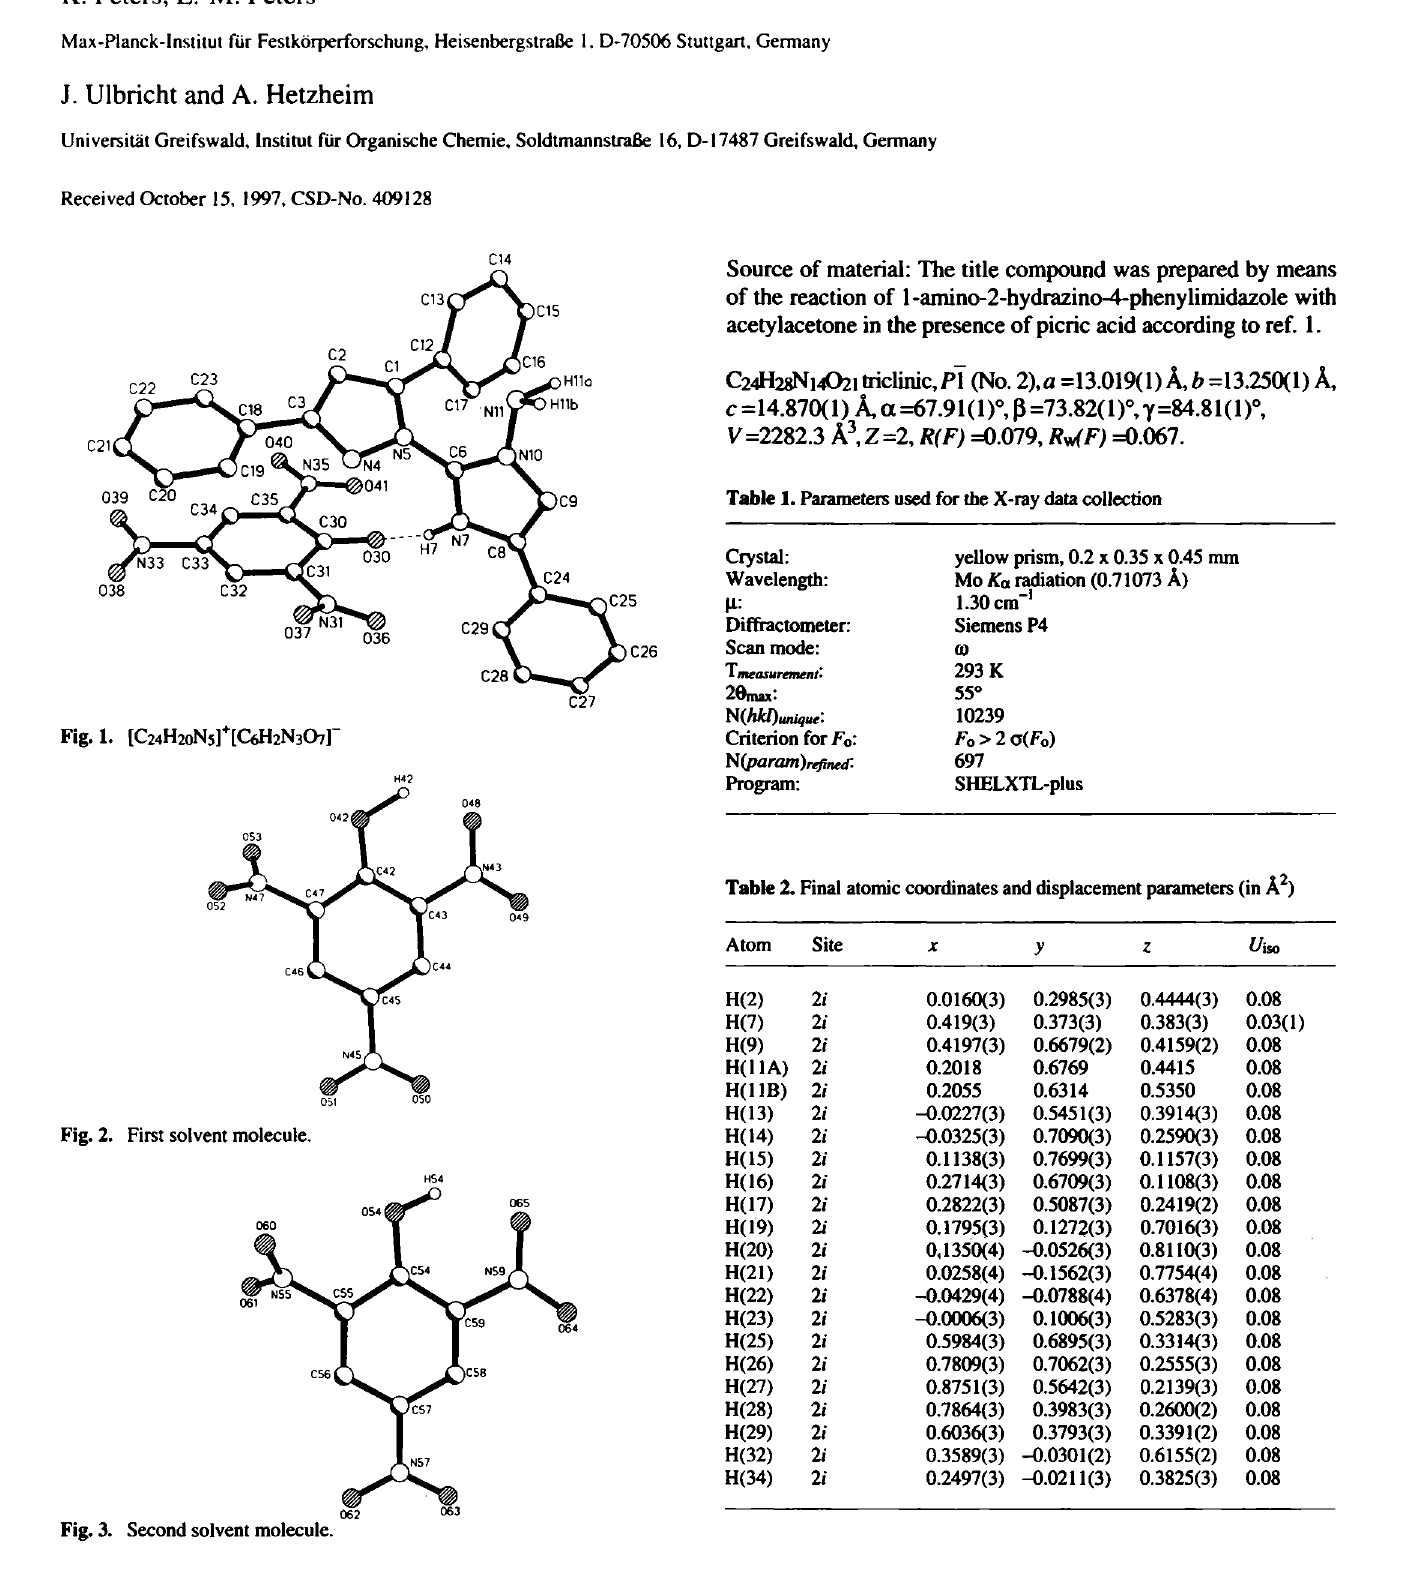
Fig. 3. Second solvent